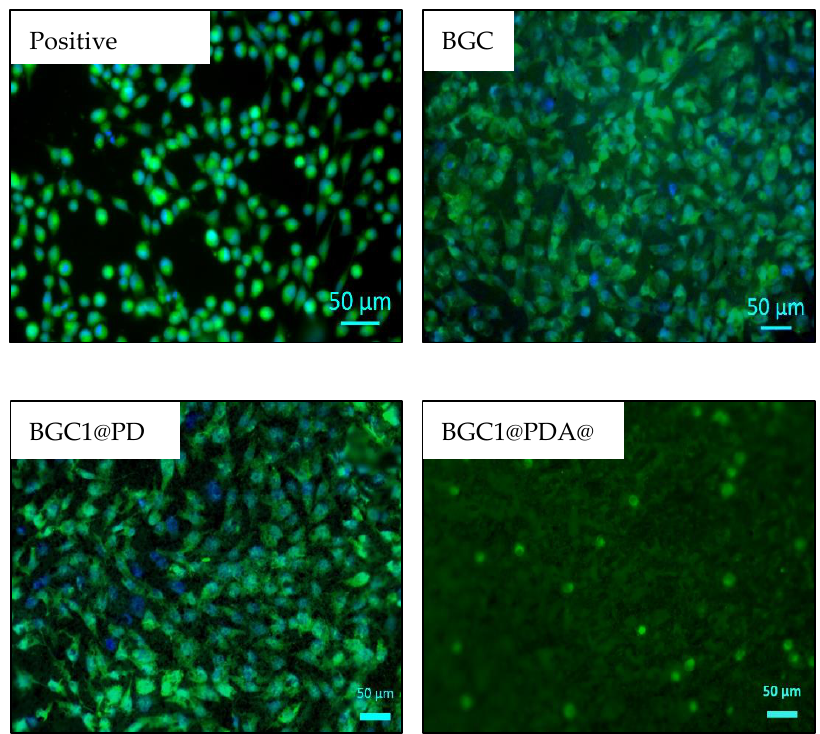
Figure 4. Viability of MG-63 cells cultured onto BGC1, BGC1@PDA and BGC1@PDA@Ag samples for 48 hours. Significant differences are indicated in comparison to control: *p < 0.05, **p < 0.01 and ***p < 0.001 (Tukey's posthoc test).